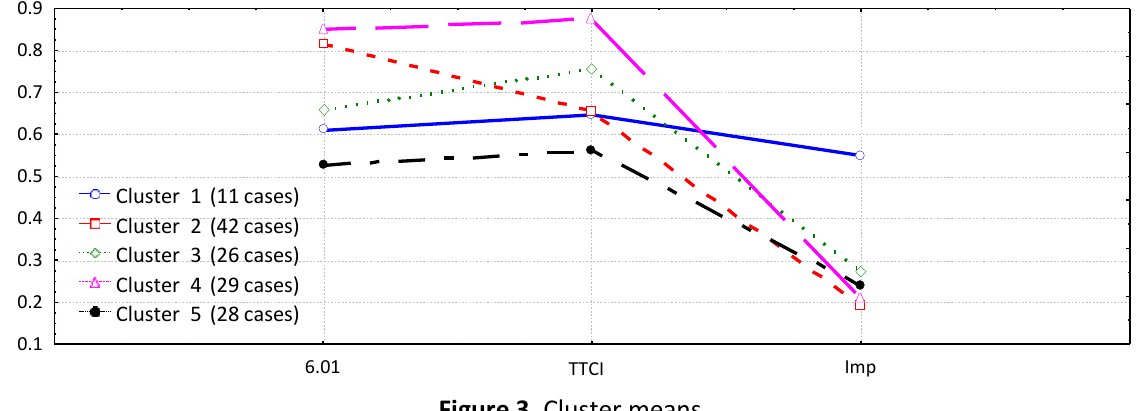
Table 3. Members and main characteristics of each cluster (calculated data) Cluster,